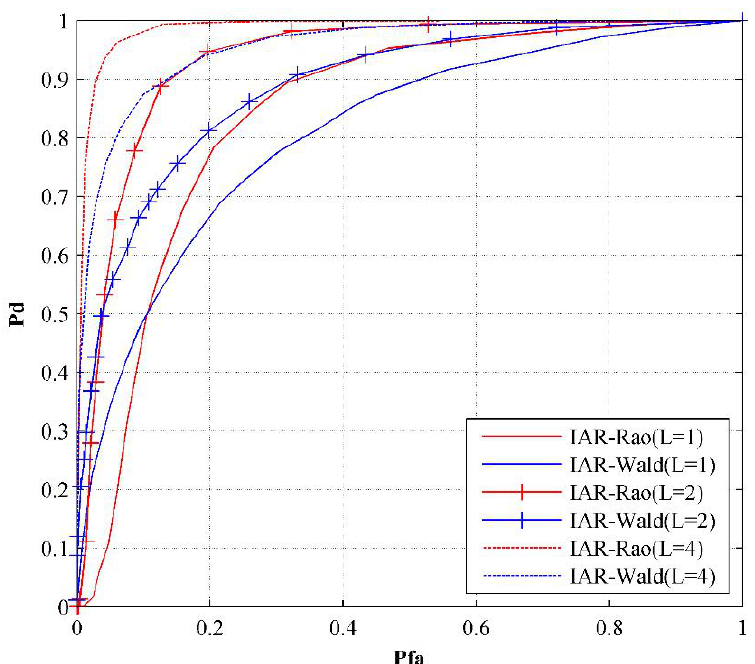
Figure 4. ROC of the IAR-Rao and of the IAR-Wald under conditions of N = 16, K = 0, SINR = 5 dB and various L